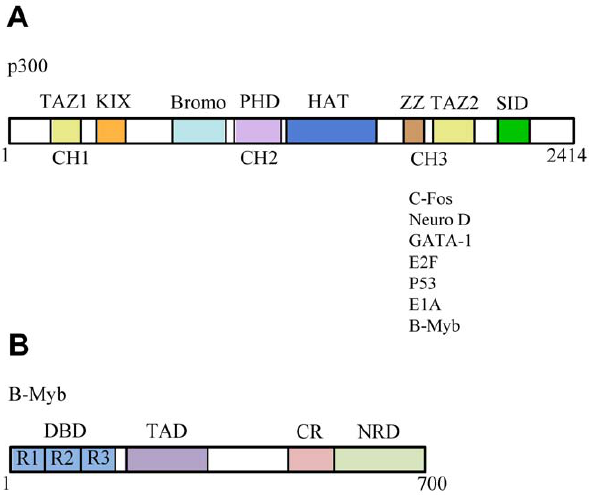
Figure 1. Schematic representations of the organisation of the functional regions and domains of human B-Myb and p300. Panel A shows the positions of functional domains in the transcriptional coactivator p300, as well as a partial list of proteins that bind to the CH3/E1A-binding region. Panel B illustrates the tripartite functional organisation of the B-Myb protein, which contains an N-terminal DNA binding region (DBD) formed by three highly homologous domains (R1, R2 and R3), a central transactivation domain (TAD), and towards the C- terminus a highly conserved region (CR) and negative regulatory domain